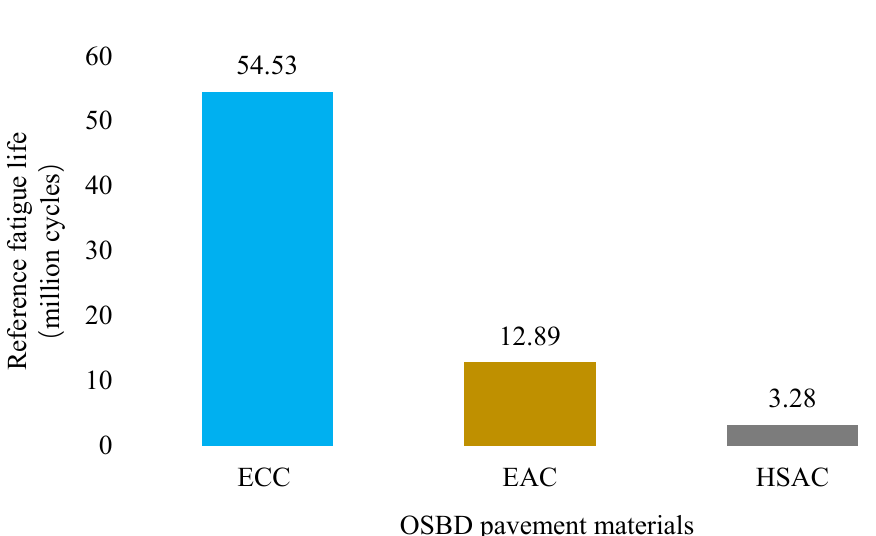
Figure 14. Reference fatigue lives of different OSBD pavement materials.